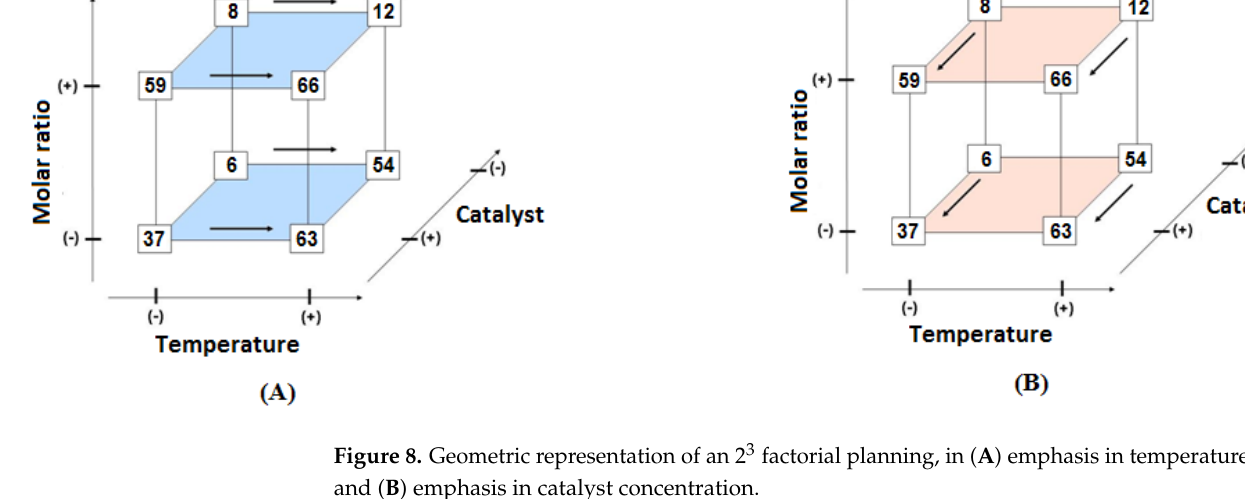
Figure 8. Geometric representation of an 2 3 factorial planning, in ( A ) emphasis in temperature effects and ( B ) emphasis in catalyst